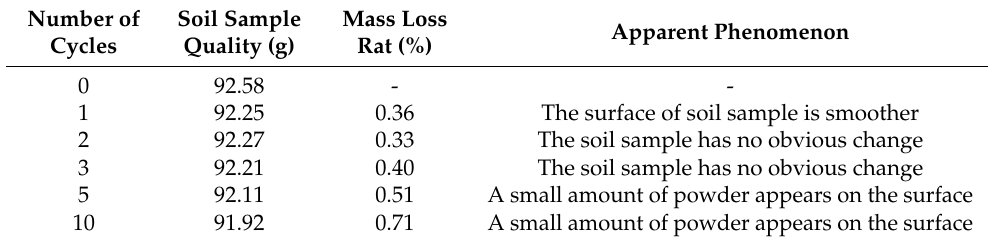
Table 5. Record of constant temperature dry wet cycle test of soil sample